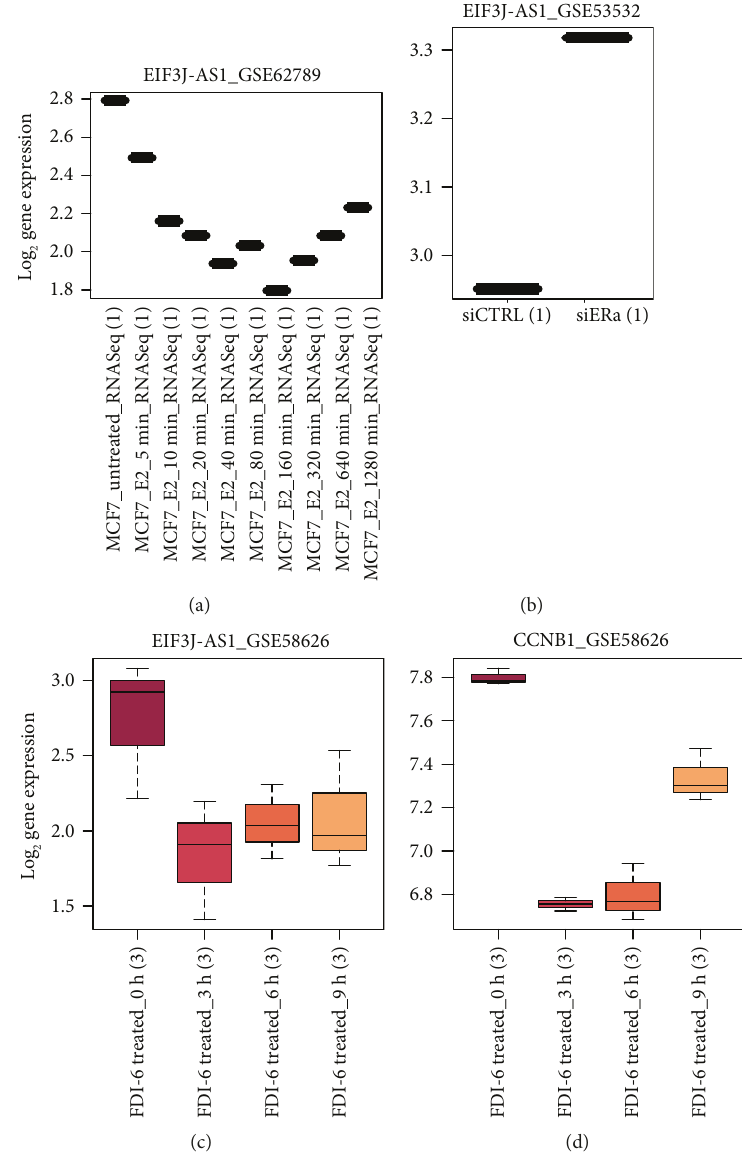
Figure 7: Functional study of EIF3J-AS1 via in vitro experiments from public datasets. (a) EIF3J-AS1 was downregulated after E2 treatment in breast cancer cell line MCF7. (b) EIF3J-AS1 was upregulated after siERa experiments in MCF7. (c) The expression of EIF3J-AS1 decreased after FDI-6 treatment. (d) CCNB1 is coexpressed with EIF3J-AS1. The expression of CCNB1 decreased after FDI-6